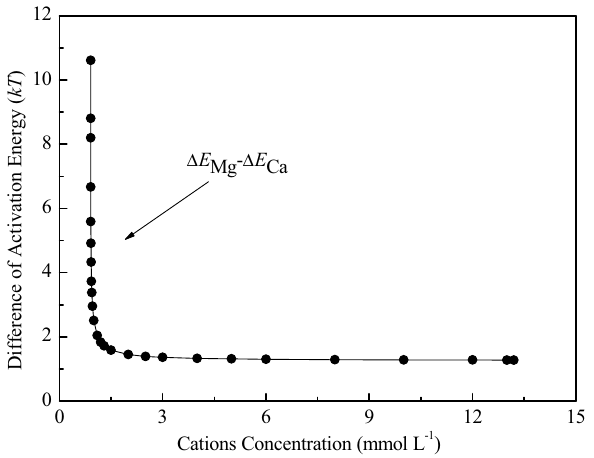
Figure 7. The correlations of the activation energy differences [∆ E Mg − ∆ E Ca ] between cations Mg 2+ and Ca 2+ with the electrolyte concentration f 0